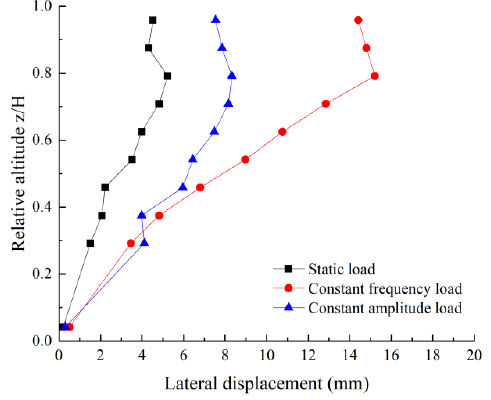
Figure 16. Lateral displacement at F = 140 kN.